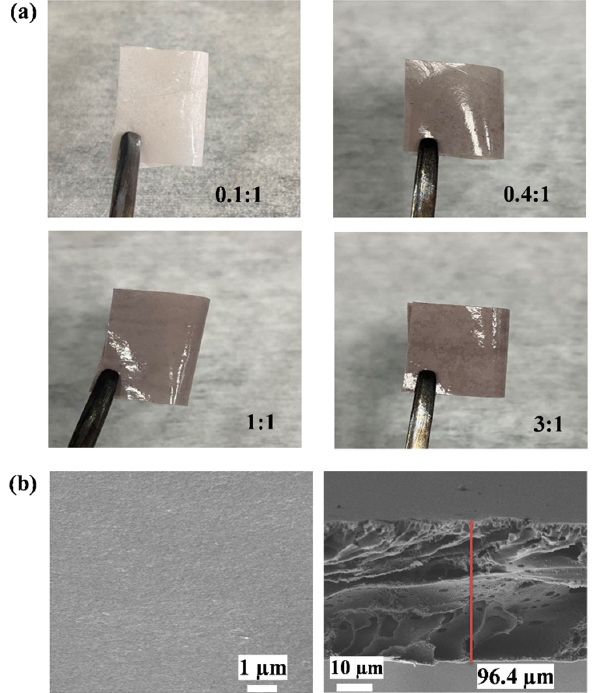
Figure 5. ( a ) Fabricated matrix-mixed membranes with different ratios of PA-PhSO 3 H :PAN. ( b ) SEM images of the upper surface ( left ) and thickness ( right ) of the fabricated matrix-mixed membrane PA-PhSO 3 H-PAN (3:1) .